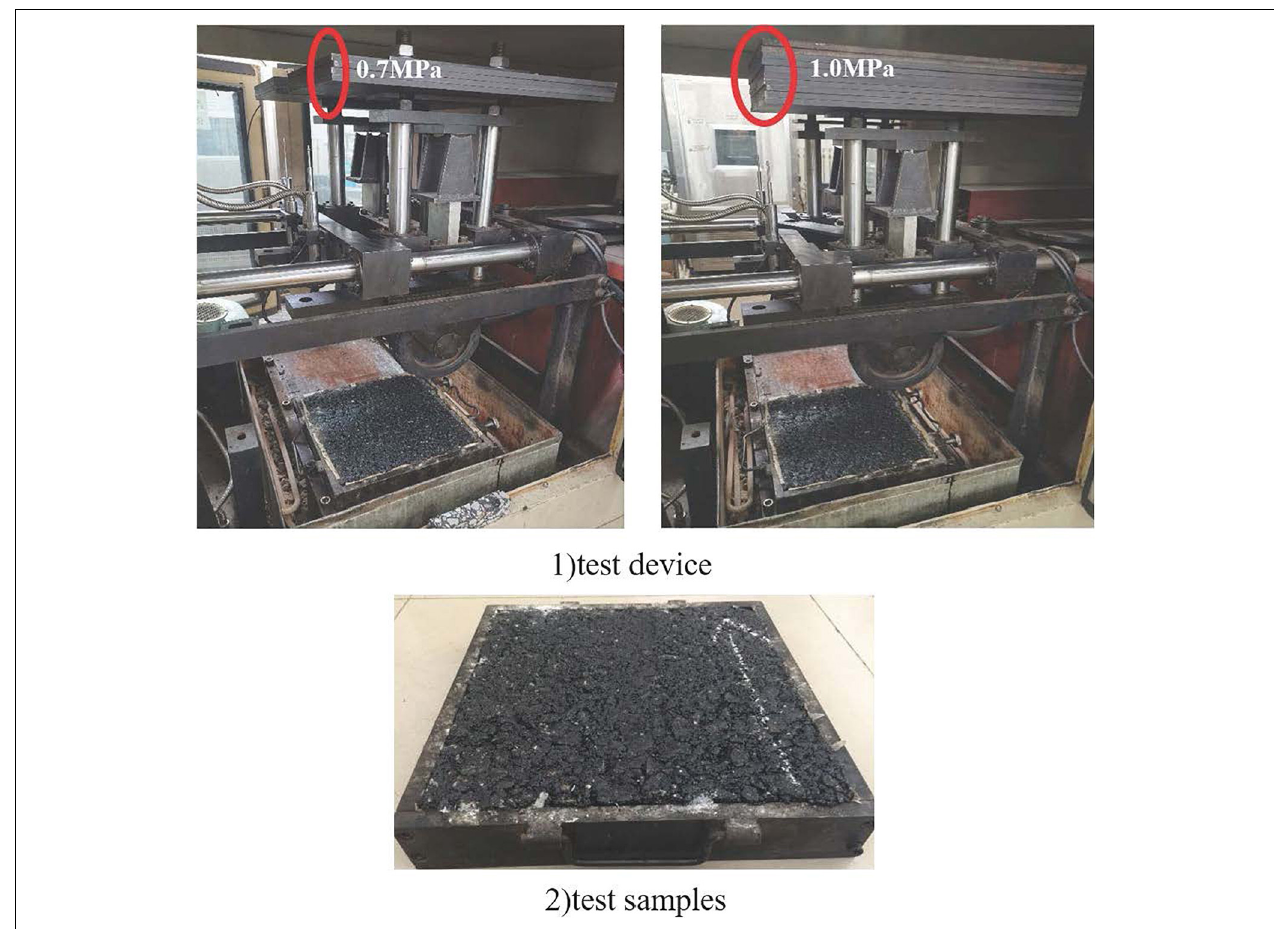
FIGURE 5 | Test device and